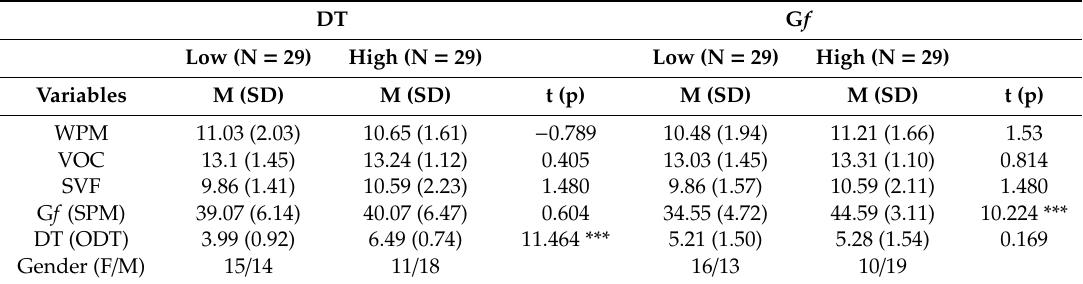
Table 2. Descriptive and inferential statistics of the groups’ dependent variables.